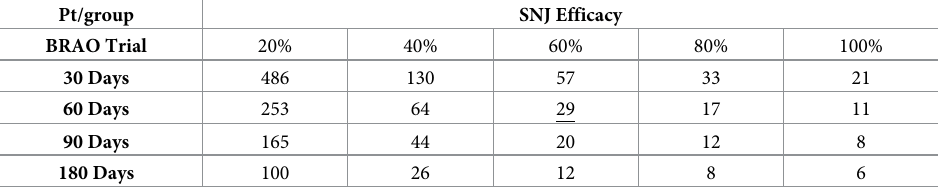
Table 1. Minimum number of patients to detect a significant protective effect of a drug against BRAO-induced GCL thickness loss. Drug efficacies (%, top horizontal row) and trial durations (left vertical column), assuming one BRAO eye and non-affected eye per